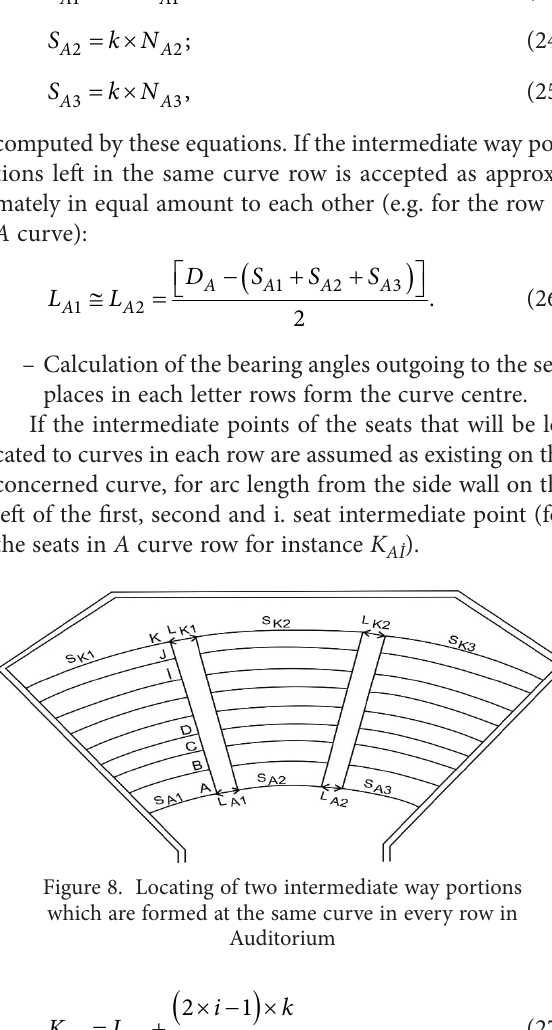
)) went to Nİ ) goes to the N